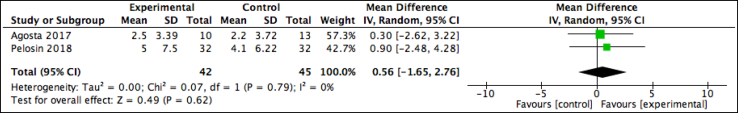
Pooled analysis for the Berg Balance Scale in patients with Parkinson disease.